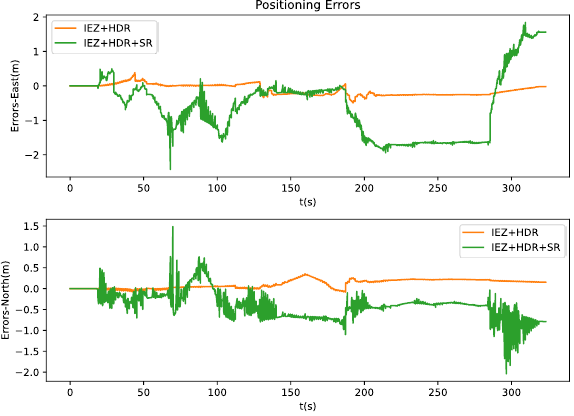
Figure 8 . Horizontal positioning errors (Experiment 1).